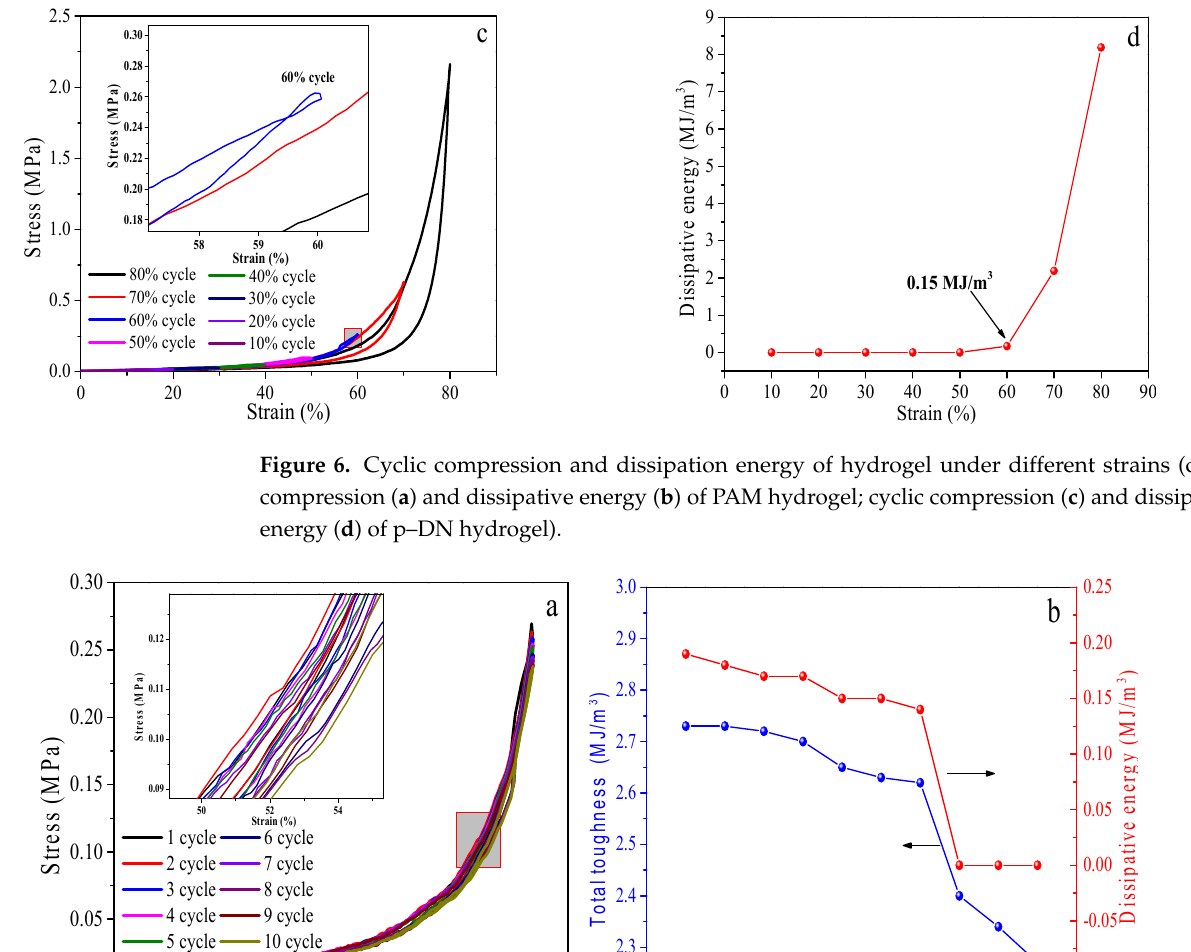
Figure 6. Cyclic compression and dissipation energy of hydrogel under different strains (cyclic com- pression ( a ) and dissipative energy ( b ) of PAM hydrogel; cyclic compression ( c ) and dissipative energy ( d ) of p–DN hydrogel).